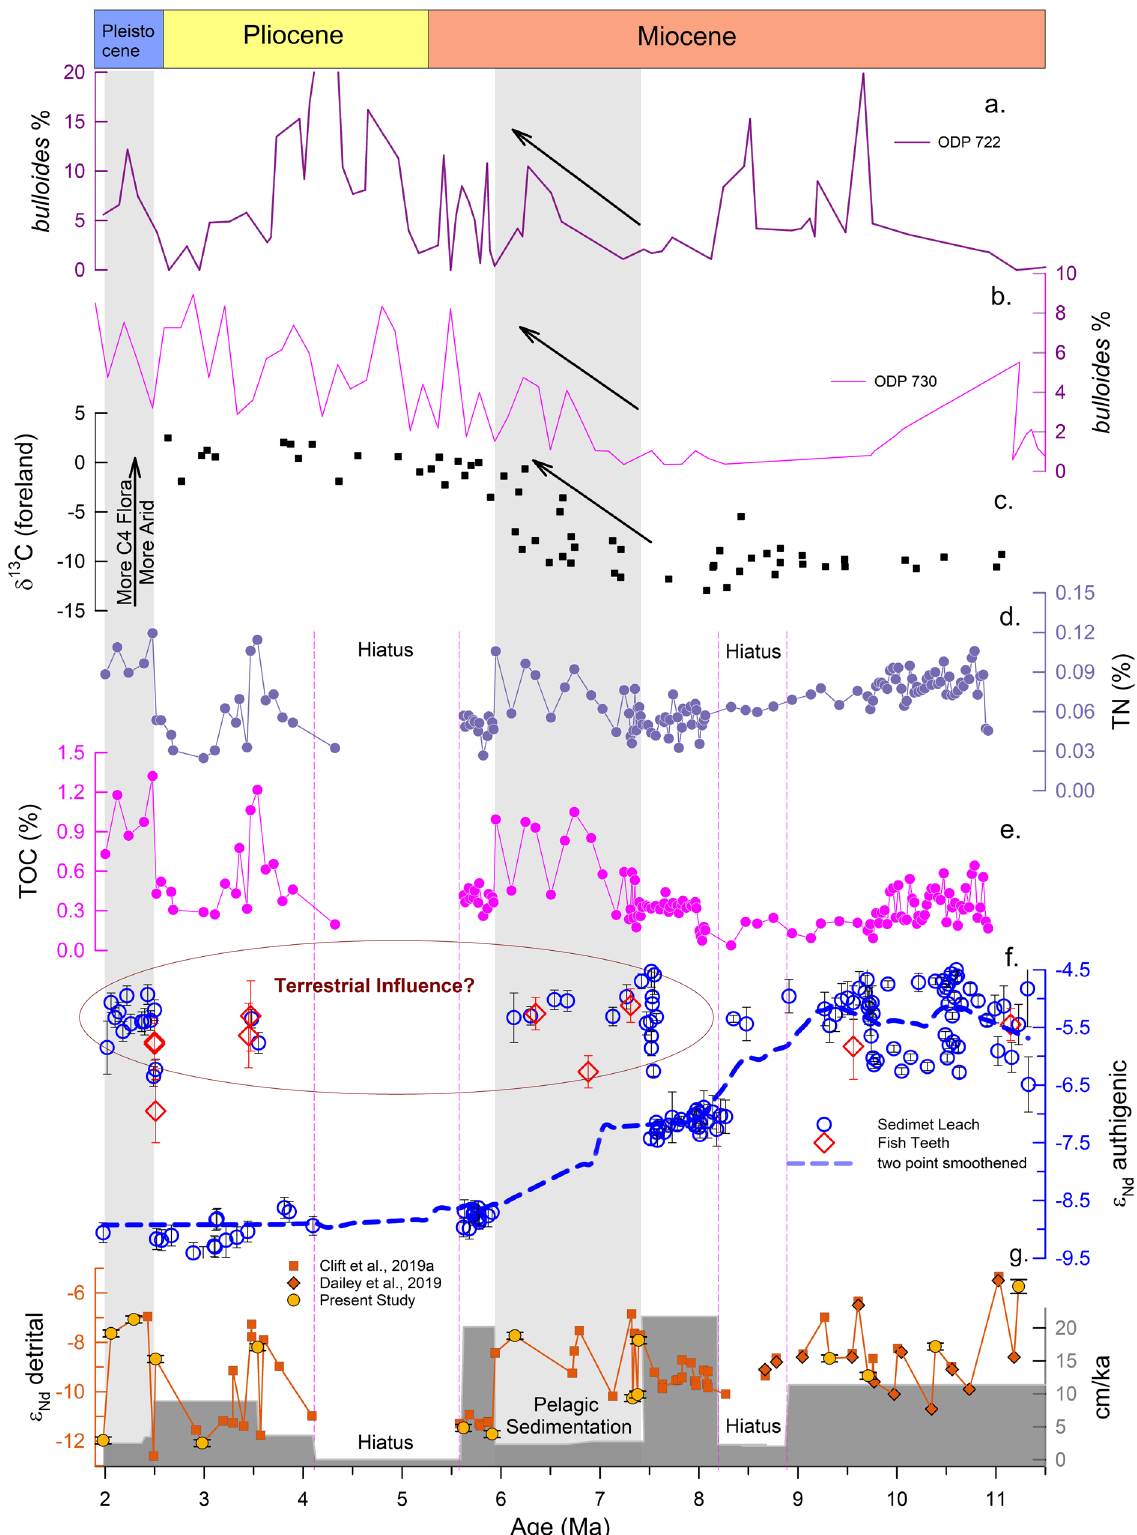
Fig. 3 | Multi-proxy records and their comparison with the authigenic ε Nd record. a , b bulloides % from the Oman Coast, Arabian Sea (recreated from ODP 722 32 , ODP 730 33 ); c δ 13 C from foreland Pakistan Siwalik 31 , d Total Nitrogen (TN, weight %) record from Site U1457 27 ; e Totalorganiccarbon (TOC, weight %) record fromSiteU1457 27 ; f Authigenic ε Nd recordofsiteU1457(presentstudy),thedashed